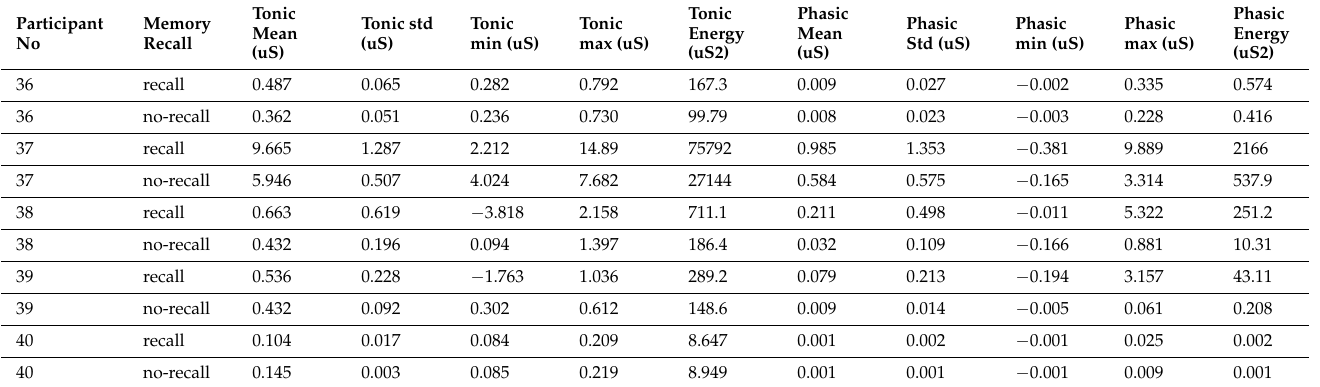
Table 7. Samples of extracted EDA